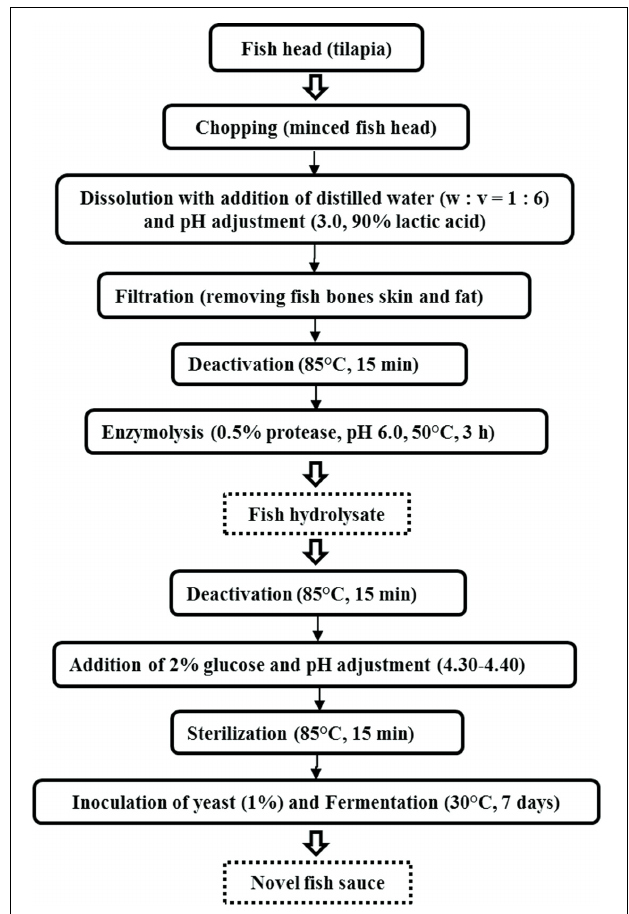
FIGURE 1 | The process for the production of fish hydrolysate and sauce.